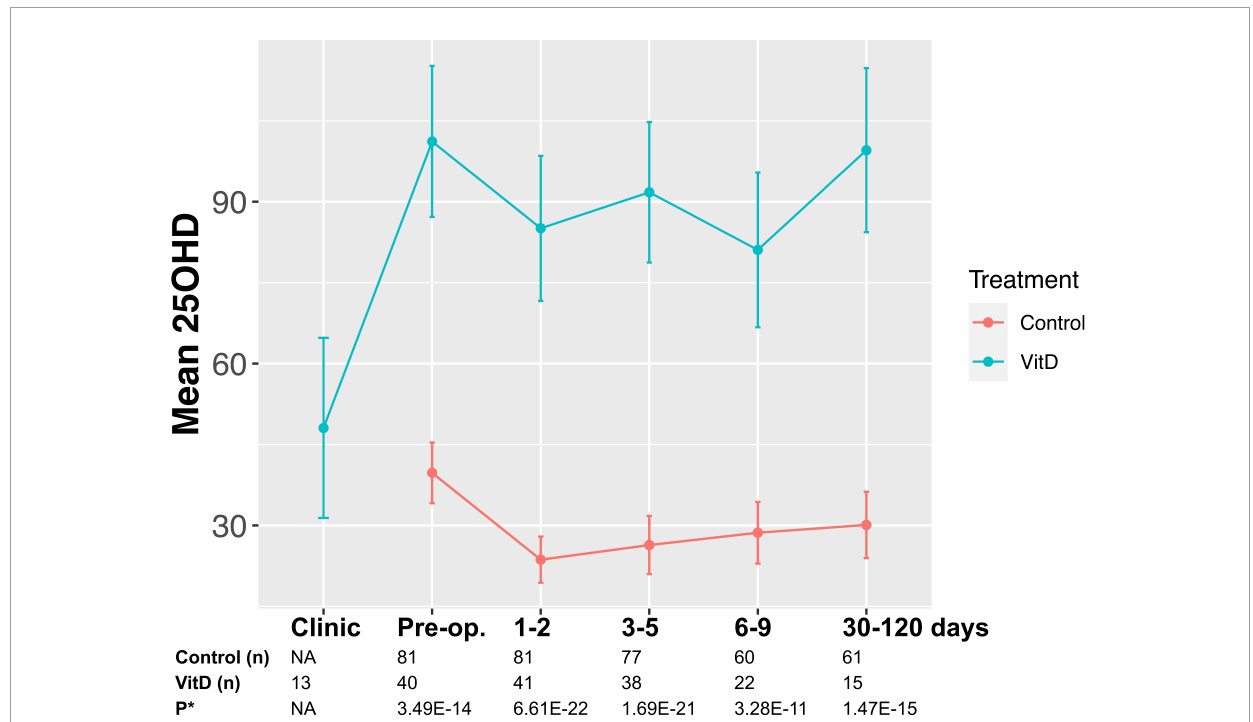
FIGURE2 Study flow diagram* indicates sample point. Median sampling days from surgery were comparable between control and supplemented subjects at timepoints 1–2, and 3–5 ( P > 0.05). However, it was noted that fewer supplemented subjects were sampled at timepoint 6–9 and 30–120 days, with sampling occurring earlier in the supplemented patients (6 vs. 7 days, P = 0.04; 39 vs. 67 days, P = 0.0001).